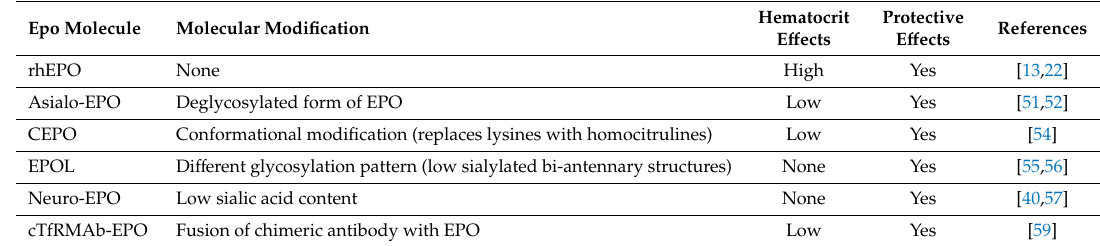
Table 1. Molecular variants of rhEPO. Asialoerythropoietin (Asialo-EPO); Carbamylated EPO (CEPO); EPOL; Neuro-EPO and an EPO analogue called cTfRMAb-EPO. All them have low or no hematocrit effects but have protective effects preserved. As reference of chronic treatment, rhEPO was included.